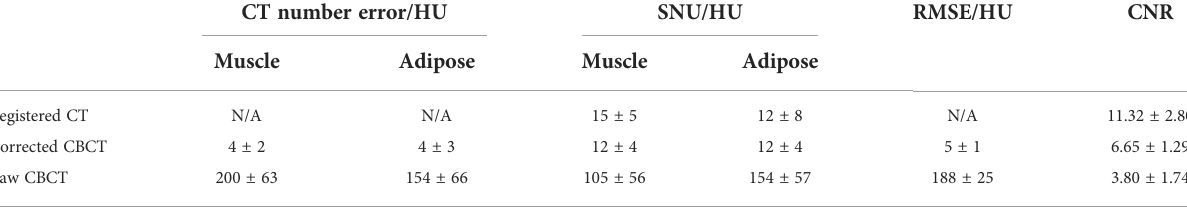
TABLE 5 Quantitative analysis of CT number error, CNR, SNU, and RMSE of fi ve patients.